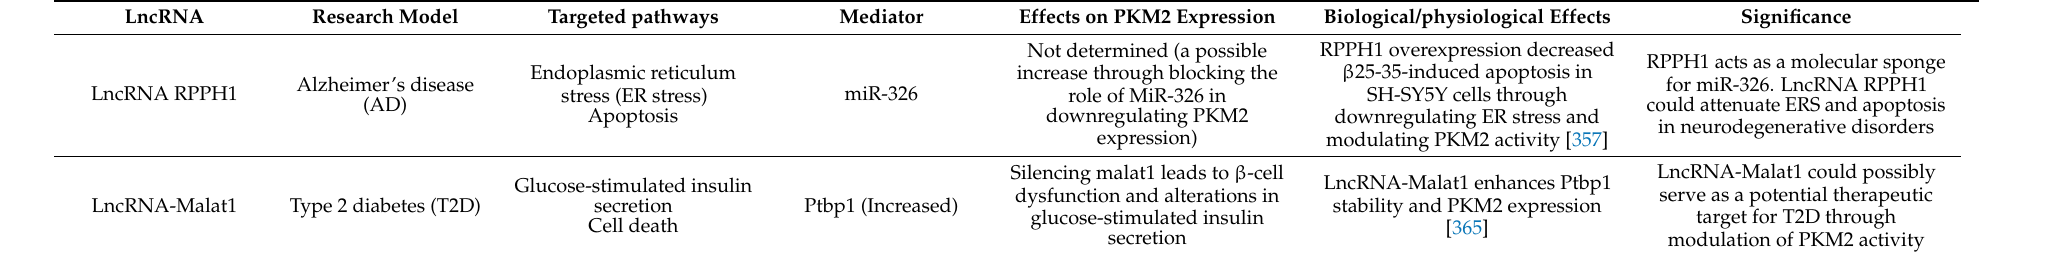
Table 4. Roles of some PKM2/long non-coding RNAs in non-cancer diseases.